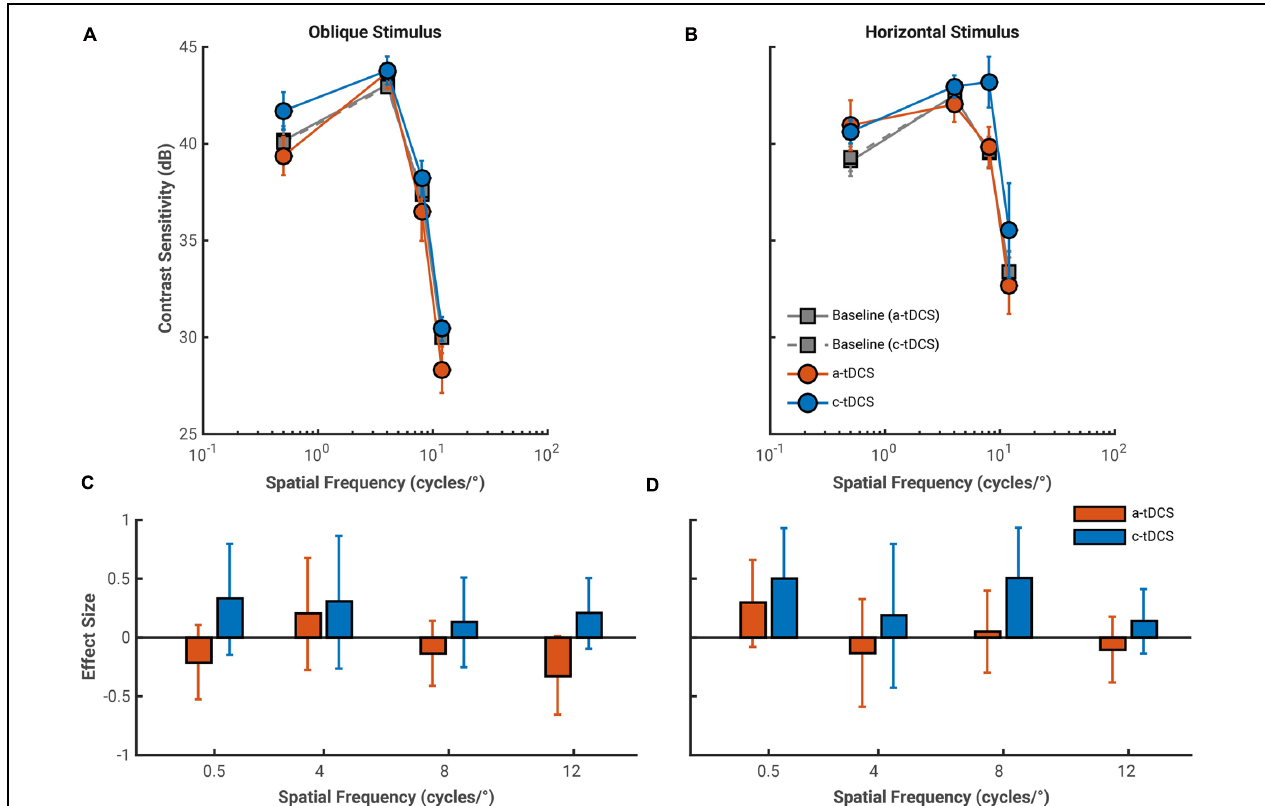
FIGURE 4 | Average pre-stimulation (gray) and stimulation CSFs for both a-tDCS (red) and c-tDCS (blue) measured with the oblique (A) and horizontal (B) fixed size gratings (at spatial frequencies of 0.5, 4, 8, and 12 cycles/ ◦ ). Contrast sensitivity is presented in decibels (dB). Error bars represent the standard error of the mean difference calculated across observers. (C,D) The effect sizes of the mean difference contrast sensitivity measured at stimulation and at pre-stimulation for oblique and horizontal conditions, respectively. We found a large increase in contrast sensitivity measured with the 8 cycles/ ◦ horizontal, fixed size grating under c-tDCS, and a potential polarity specific effect of tDCS on contrast sensitivity measured to oblique gratings at a spatial frequency of 12 cycles/ ◦ . Error bars represent the exact 95% confidence interval of the effect size. As in figure, we used error bar overlap to assess the magnitude of tDCS effects on contrast sensitivity.